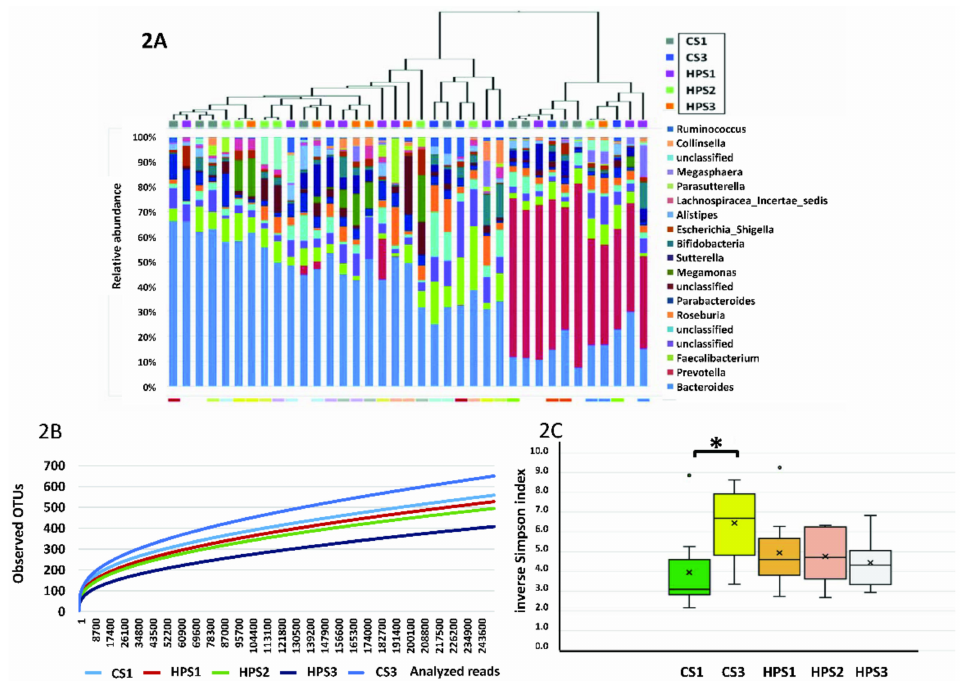
Figure 2. The dendrogram of hierarchical clustering and microbiota composition at the genus level in the 37 fecal samples ( A ). The rarefaction curves ( B ) and inverse Simpson index ( C ) of microbiota between the five groups (CS1: non- H. pylori infected controls at enrollment; CS3: non- H. pylori infected controls 4 weeks after yogurt ingestion; HPS1: H. pylori -infected children at enrollment; HPS2: H. pylori -infected children after 4 weeks of yogurt ingestion; HPS3: H. pylori -infected children 4 weeks after eradication therapy. * p <